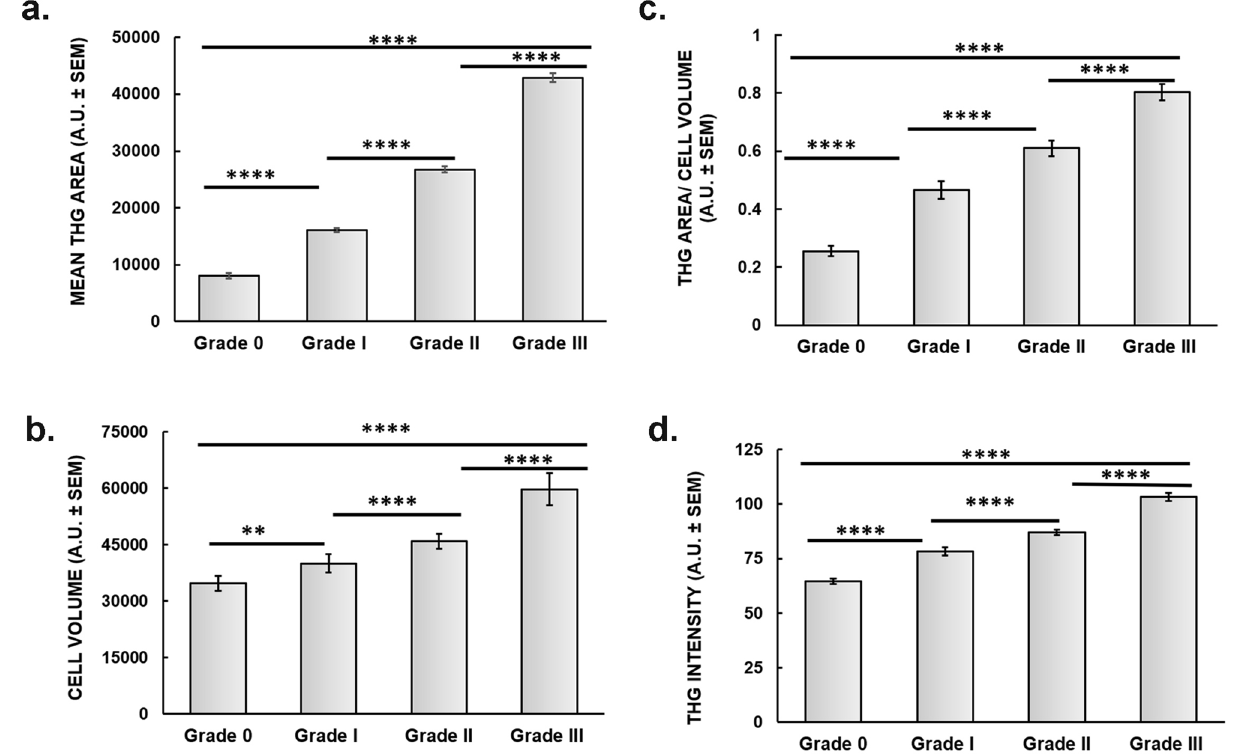
Figure 4. Quantification of non-linear measurements. Quantification of THG area of breast tissues ( a ) Quantification of cell volume ( b ) Quantification of mean THG area divided with cell volume ( c ) Quantification THG signal intensity ( d ). (N = 15 patients). N = 150 cells were tested from each category. For the statistical analysis (****) indicates p < 0.0001, (***) p < 0.001, (**) p < 0.01 and (*) p <